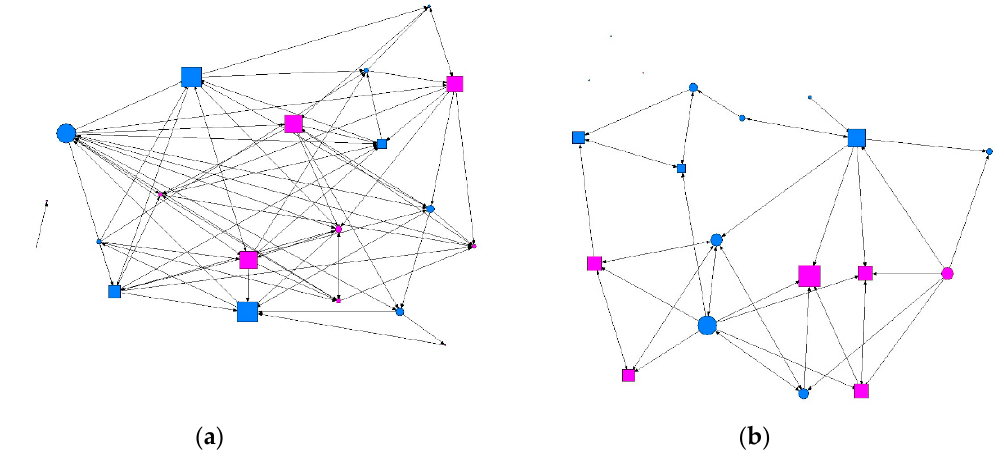
Figure 3. Graph of intermediate contact intensity in a class. Males are shown in blue and females in pink; circles represent individuals whose consumption did not present a risk and squares represent individuals showing at-risk use. Graphs produced using UCINET software [48]: ( a ) where the size of the nodes indicates the degree of intermediation (betweenness); ( b ) where the size of the nodes indicates the degree of ties (degree).